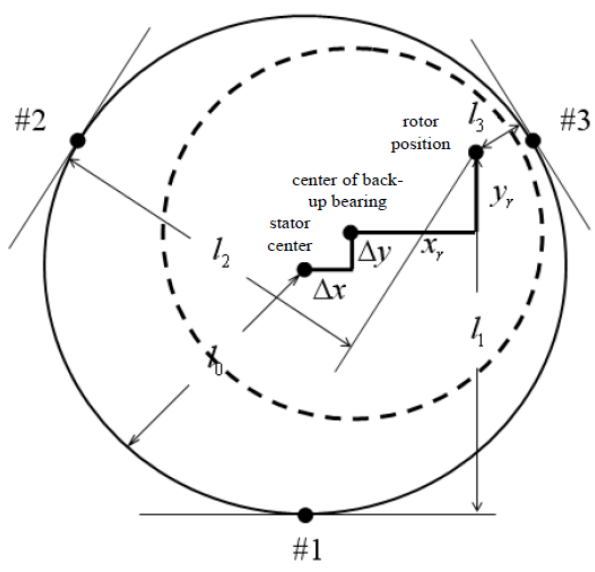
Figure 2. The rotor position with assembly error.